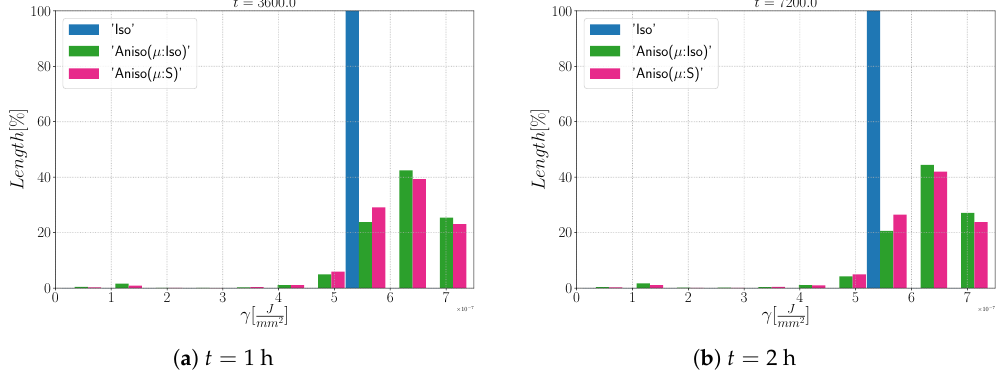
Figure 29. ( a ) t = 1 h and ( b ) t = 2 h for the isotropic (Iso) formulation and anisotropic formulations with isotropic GB mobility (Aniso( µ :Iso)) and heterogeneous GB mobility (Aniso( µ :S)). The Y-axis represents the GB length percentage. Numerical results are obtained from the initial immersed microstructure shown in Figure 25a and the GB5DOF code to define the GB